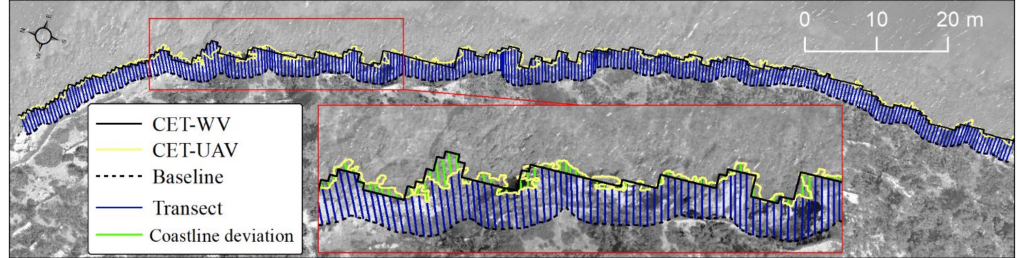
Figure 7. The calculation of the coastline deviation (green) for the CET-WV coastline within the transects created by DSAS.